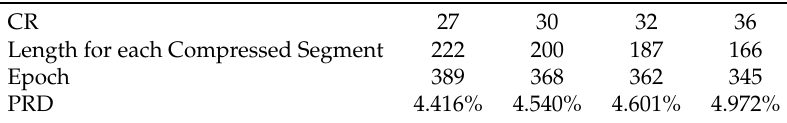
Figure 4. Compressed signals (( a ) for the time duration of 3 s (segment length of 6000) and ( c ) for the time duration of 4 s (segment length of 8000)) and comparisons between original data with the reconstructed signal (( b ) for the time duration of 3 s (segment length of 6000) and ( d ) for the time duration of 4 s (segment length of 8000)). Zoom-in plots during 0.2 to 0.6 s for ( b , d ) are illustrated in ( e , f ), respectively. Table 4. CR Evaluation at a segment length of